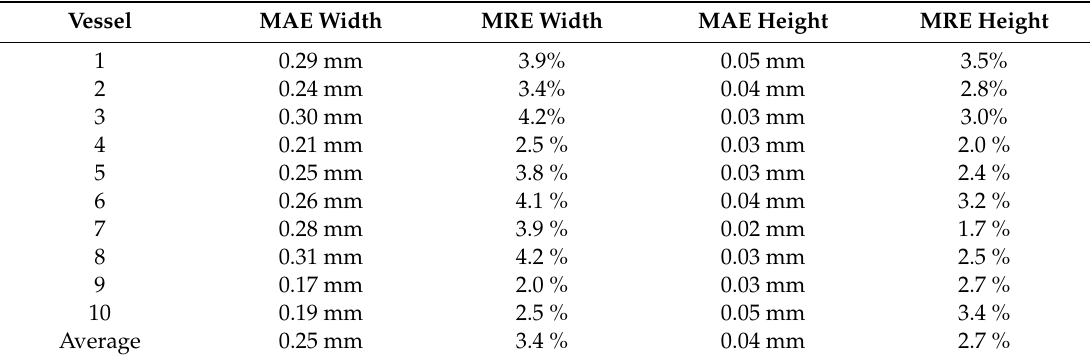
Table 2. Maximum absolute error and maximum relative error per